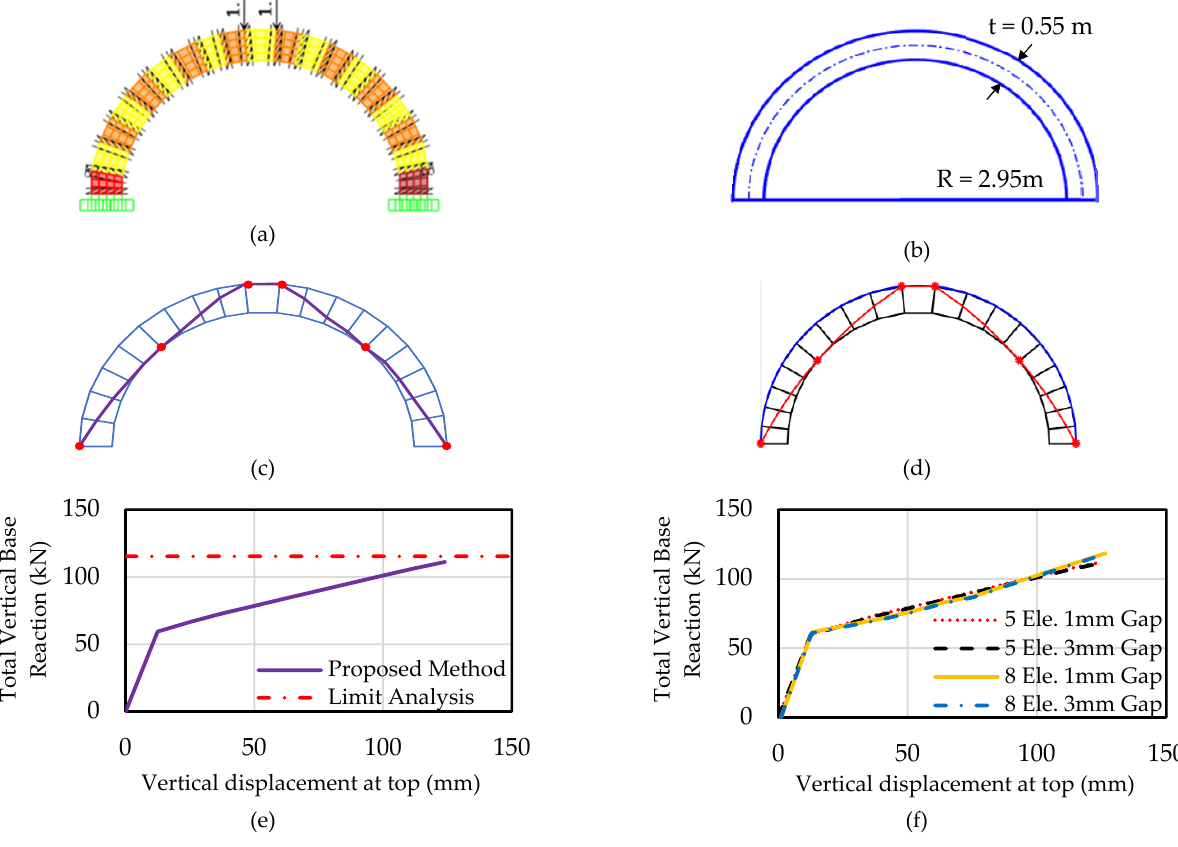
Figure 3. Comparison of limit analysis and proposed modelling: ( a ) Proposed model; ( b ) ArchNURBS model; ( c ) Hinging (proposed model); ( d ) Hinging (ArchNURBS); ( e ) Capacity curves and ( f ) Mesh Sensitivity Results.